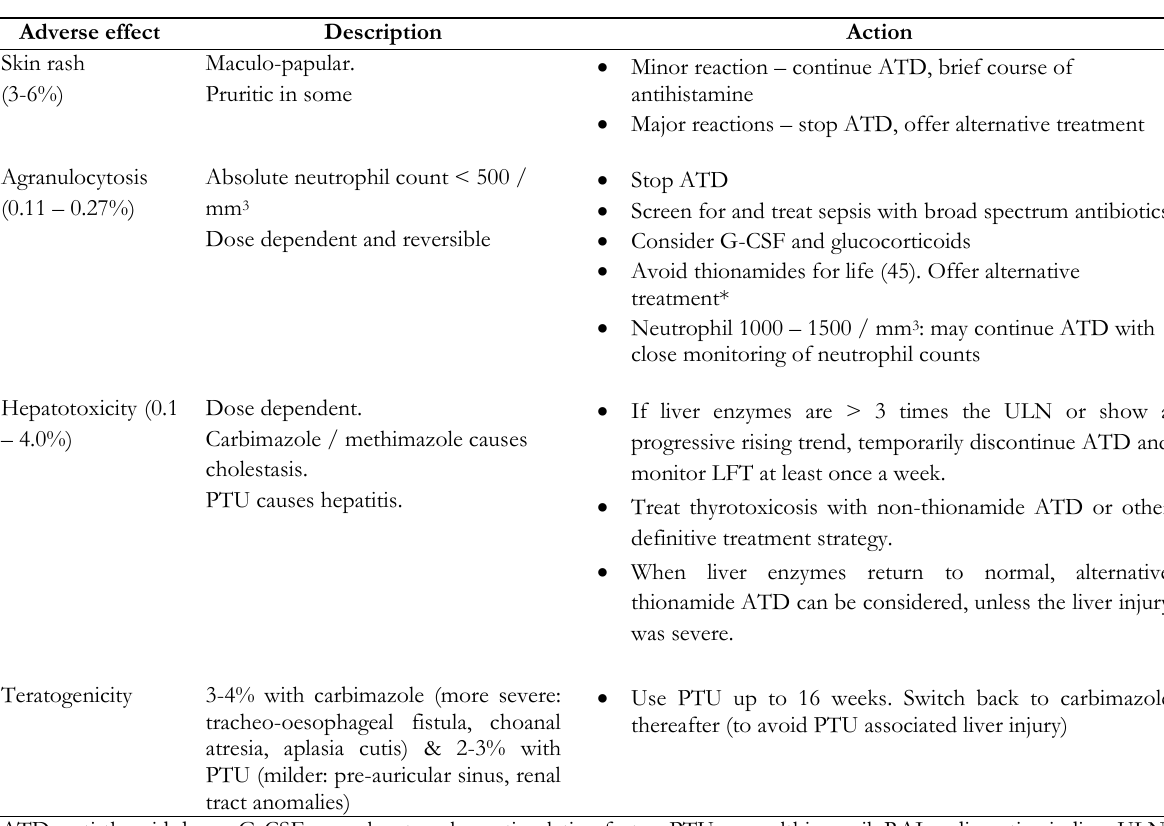
Table 3.9. Adverse effects of thionamide anti-thyroid